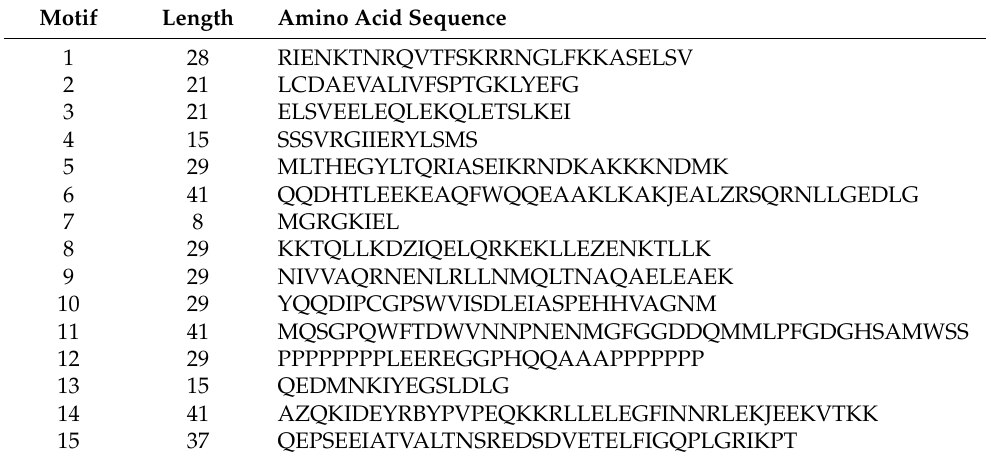
Table 1. Conserved motifs of blueberry MADS-box